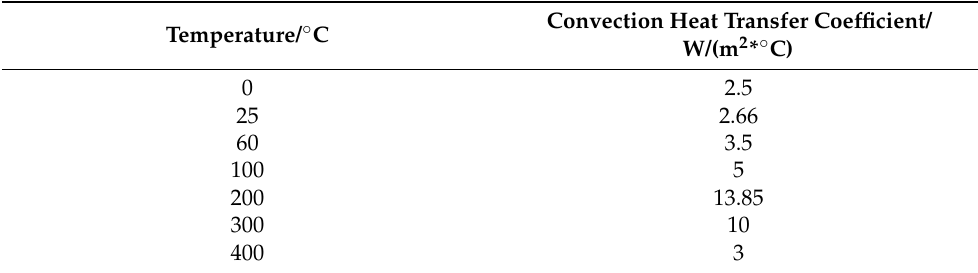
Table 3. Convection heat transfer coefficient of